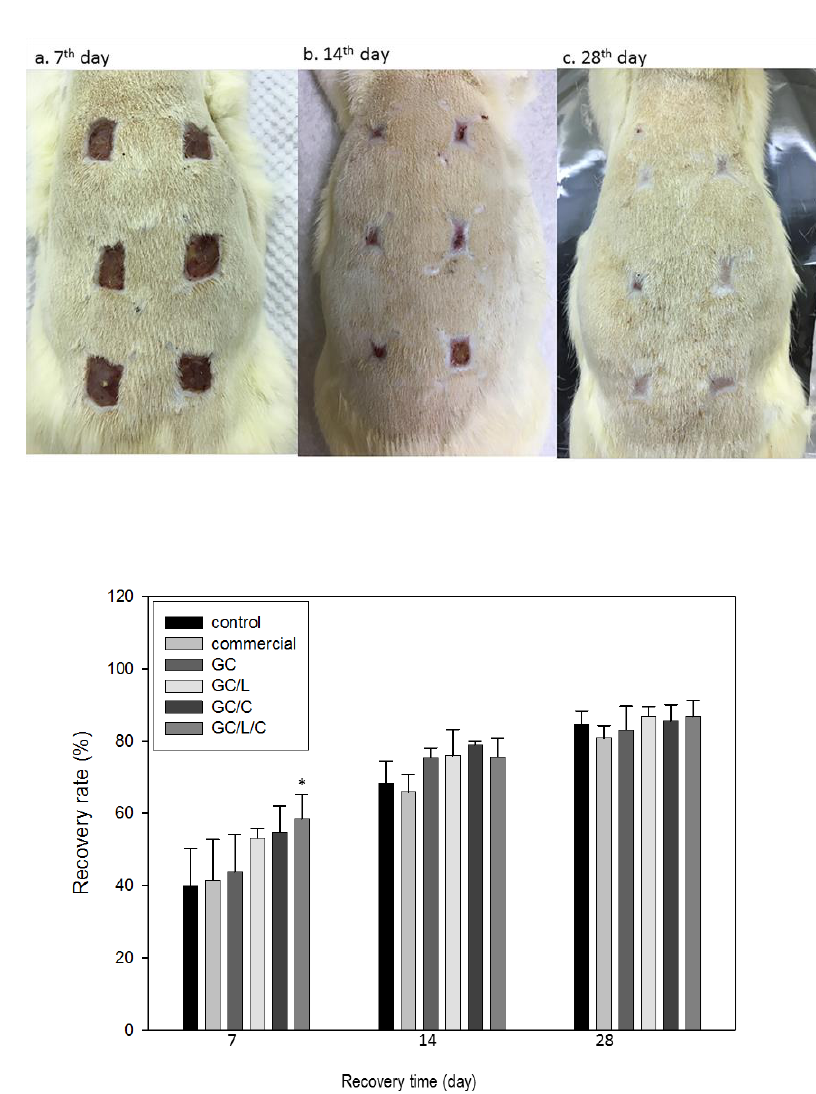
Figure 7. ( A ) Photographs of the wound areas that were treated with a GC, GC / L, GC / C, and GC / L / C scaffolds, commercial (Comfeel ® ) or gauze (control) at seventh day ( a ), 14 th day ( b ) and 28 th day ( c ). The arrangements of various membranes’ positions on the rats were changed randomly. ( B ) The recovery rates of wounds with various treatments. The surface area changes of the wound were monitored from four animals in each group. *Compared with the control group, p <